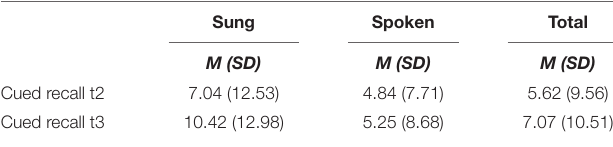
TABLE 5 | Performance cued recall of Song A (max. 21): means and standard deviations for vocabulary learning and grammatical accuracy at t2. Sung